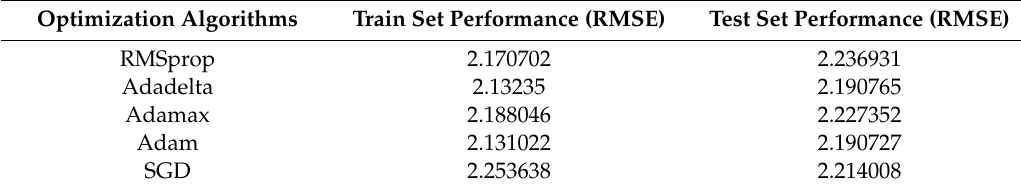
Table 1. Model’s performance when using di ff erent optimization algorithms /